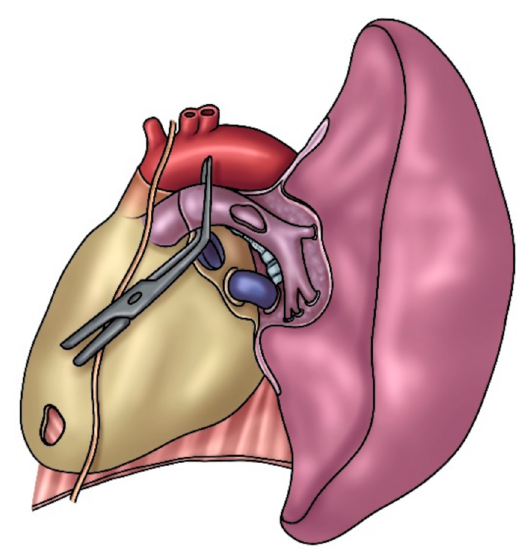
Figure 3. Left PA reconstruction with a patch of autologous pericardium. The pericardial defect is visible in the site of the leaflet